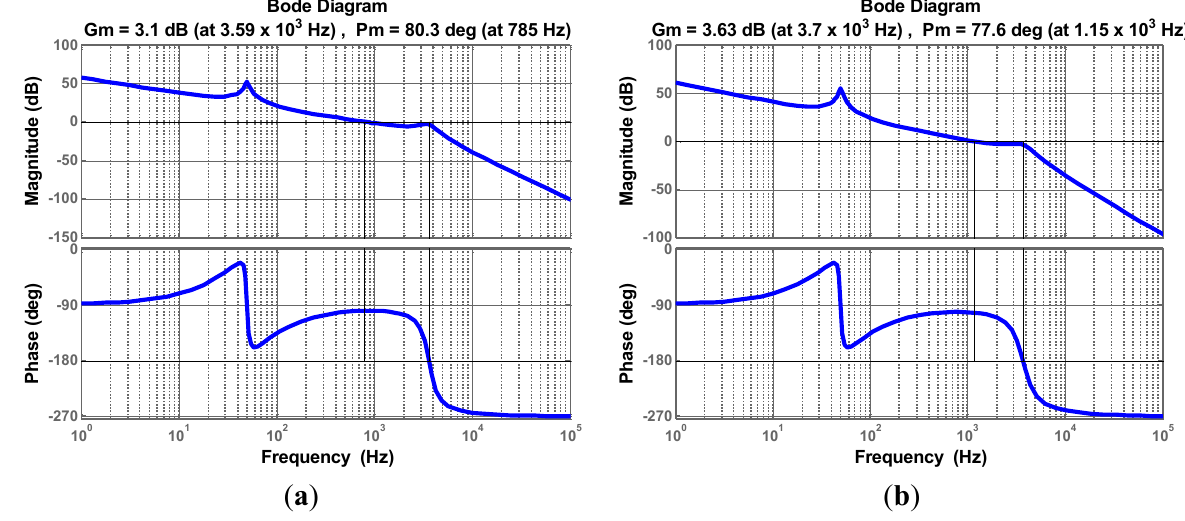
Figure 12. System Bode diagram under different parameters: ( a ) inductor L 20%; ( b ) inductor L decreased by 20%. 1